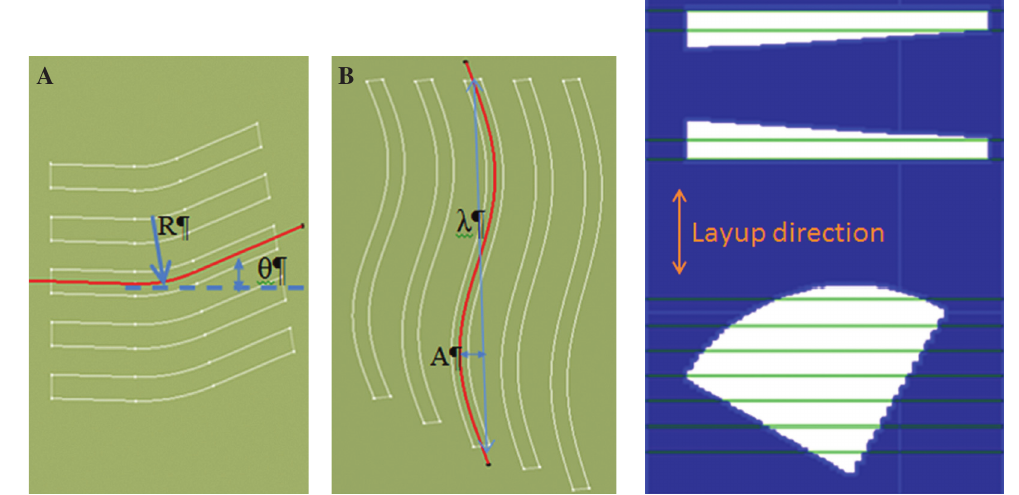
Figure 1 Fiber steering: (A) trial 1 and (B) trial 2. Figure 2 Cut/restart